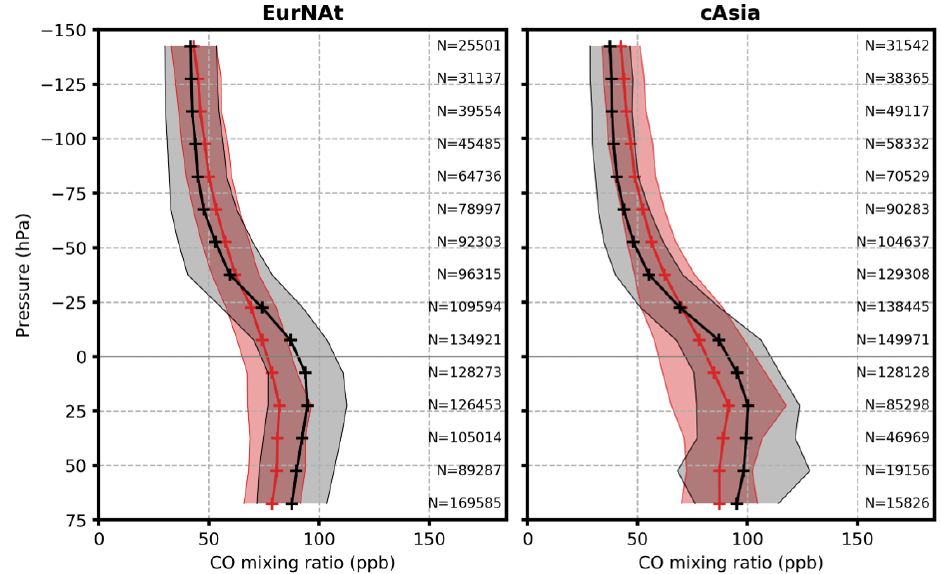
Figure 12. Comparison between IAGOS (in black) and MOCAGE INJH (in red) for the 2013 mean vertical CO profiles in the two geograph- ical areas EurNAt and cAsia defined in Fig. 1. Pressure is relative to the dynamical tropopause, defined as the 2 PVU isosurface. The shaded grey and red areas represent, respectively, the standard deviation around the IAGOS and MOCAGE means. The number of data points used for each pressure level is indicated on the right side of each